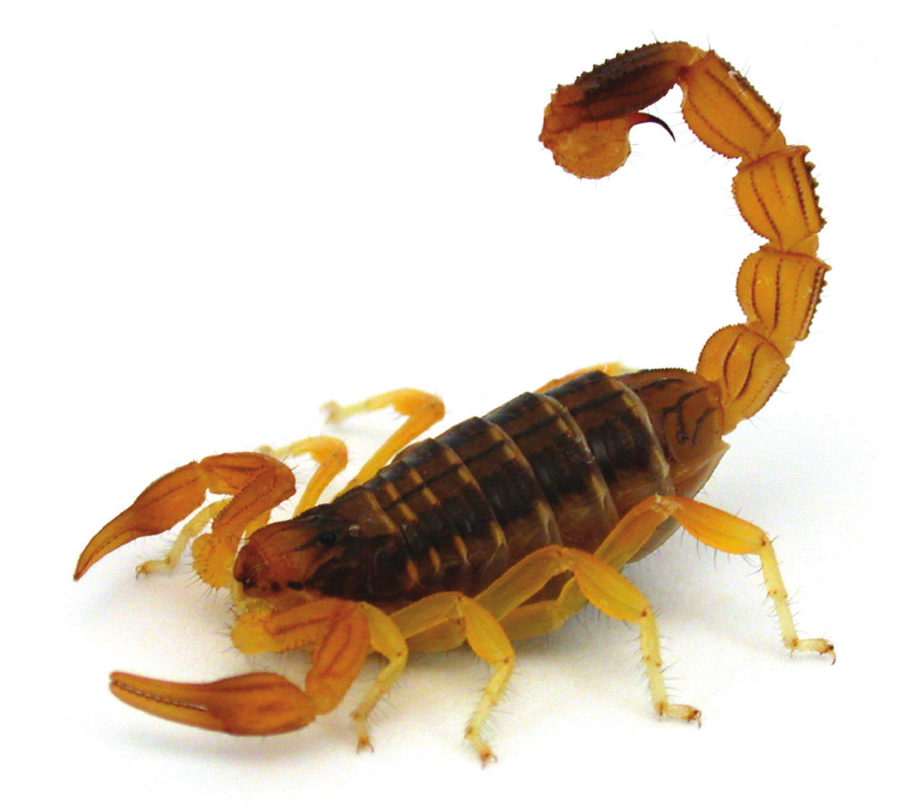
Figure 1. Buthus mariefranceae , from south of Morocco. Photo by Arie van der Meijden.